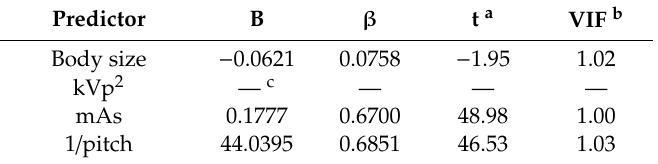
Table 7. Results of multivariate analysis for the head scans performed using MDCT H ( R 2 = 0.8854). Predictor